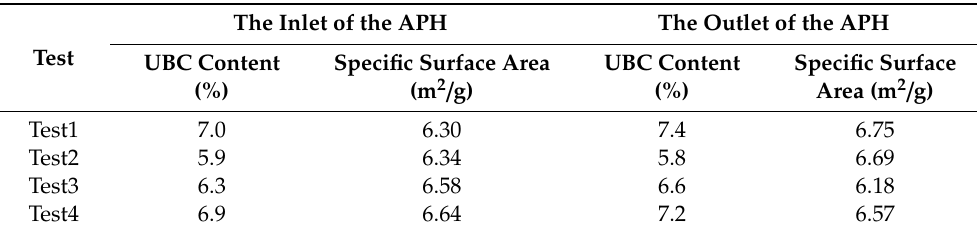
Table 3. The UBC content and specific surface area of the fly ash samples collected from the inlet and the outlet of the APH.